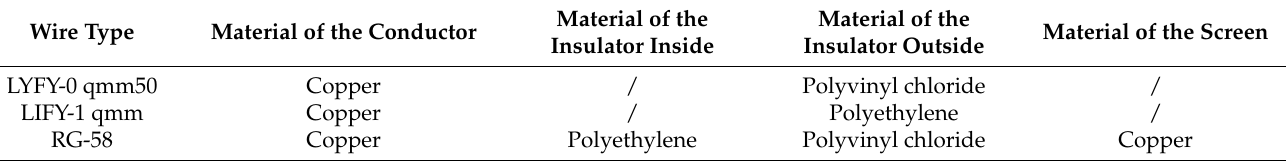
Table 4. Other parameters of the wires.